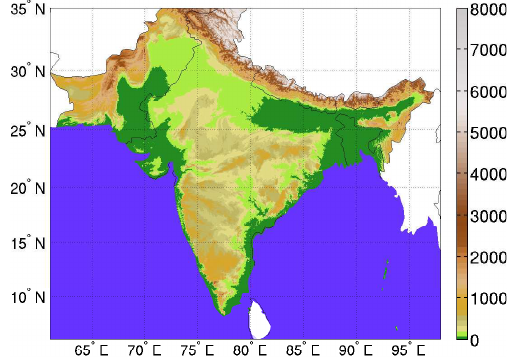
Fig. 1: Topographic map of the region concerned in the data Fig. 1. Topographic map of the region concerned in the data set and the analysis. The colour represents the height above sea level in set and the analysis. The colour represents the height above meters. This map is obtained from ETOPO1, the 1arcmin gridded sea level in meters. This map is obtained from ETOPO1, the global relief data provided by 1 arc minute gridded global relief data provided by NOAA